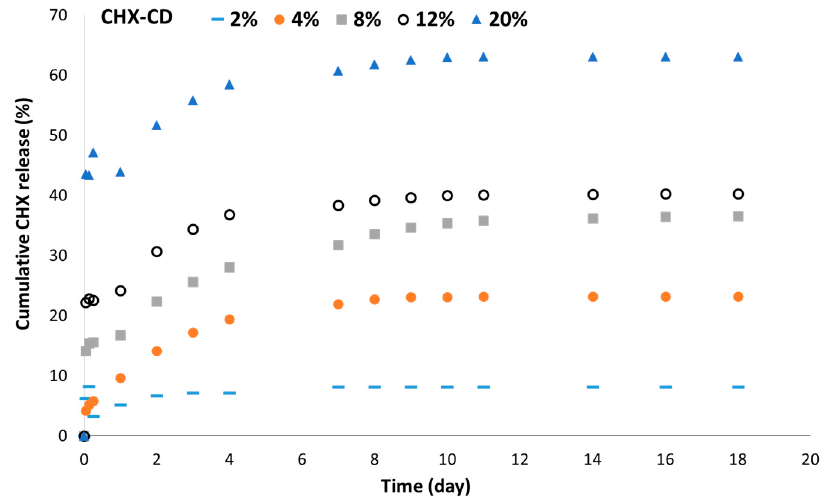
Figure 7. Cumulative CHX release according to the CHX-CD loading with the formulation PLGA/PLC (60:40), measured by UV spectrometry.